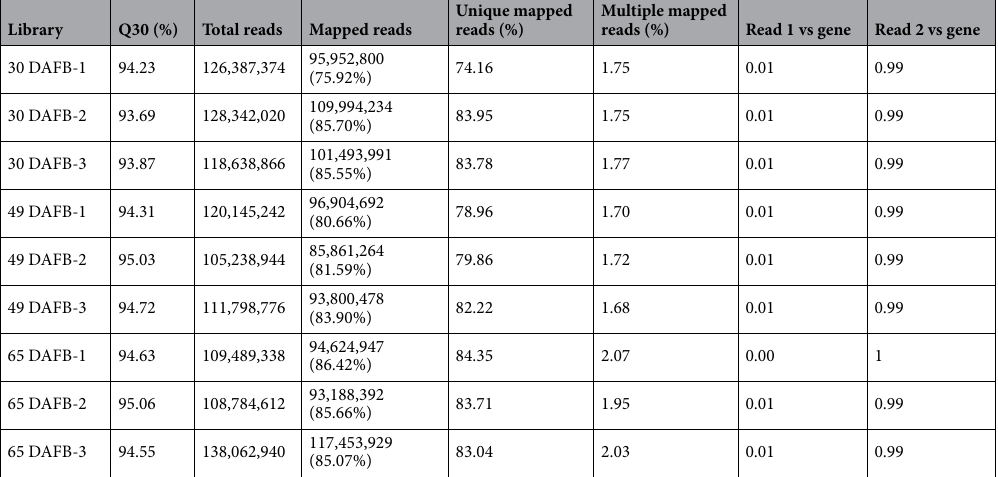
The distribution of lncRNA transcripts identified in this study on the genome was illustrated by Circos plot (Fig. 1D). It is obvious that the lncRNAs identified in this study were not distributed uniformly in the genome. For example, intronic lncRNAs identified in this study were only present on chromosomes 2, 3, 4 and 6, but not on the other four chromosomes. Antisense-lncRNAs identified in this study were distributed on each part of chromosome 4, but sense-lncRNAs identified in this study were almost only present on the end but not the other part of chromosome 4. However, it should be noted that the lncRNAs identified in this study were only derived from fruits, therefore their distribution may be different from that of the overall lncRNAs of peach from various tissues. To estimate the sequence conservation of lncRNAs at the inter-species level, the lncRNAs identified in this study were used as queries to blast against the NONCODE 35 database to search for homologies from other